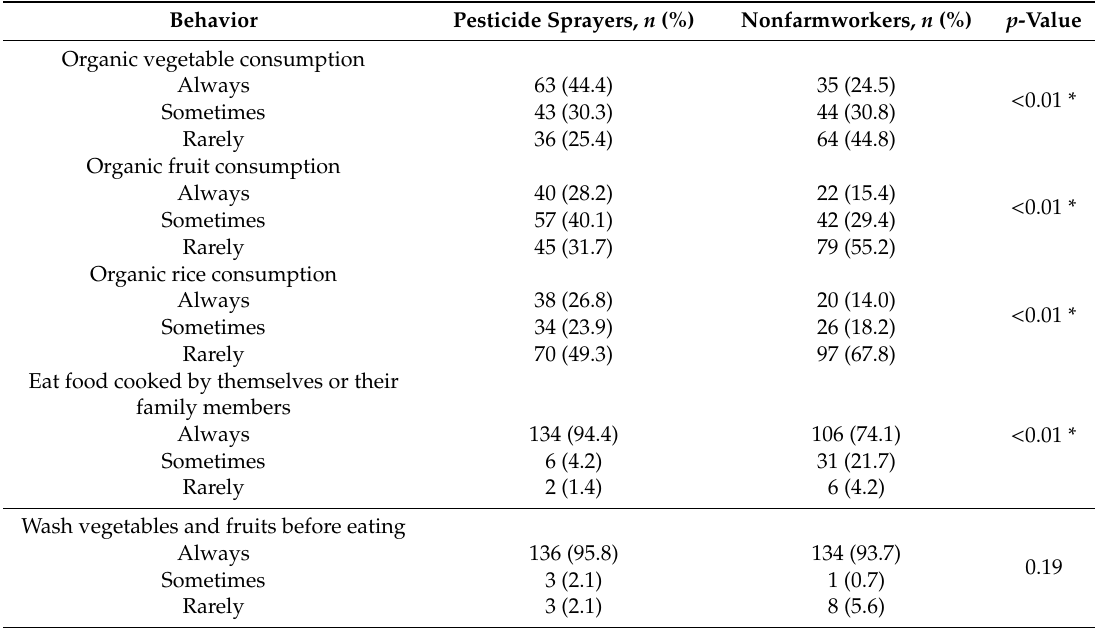
Table 3. Agricultural consumption behavior in pesticide sprayers and nonfarmworkers.